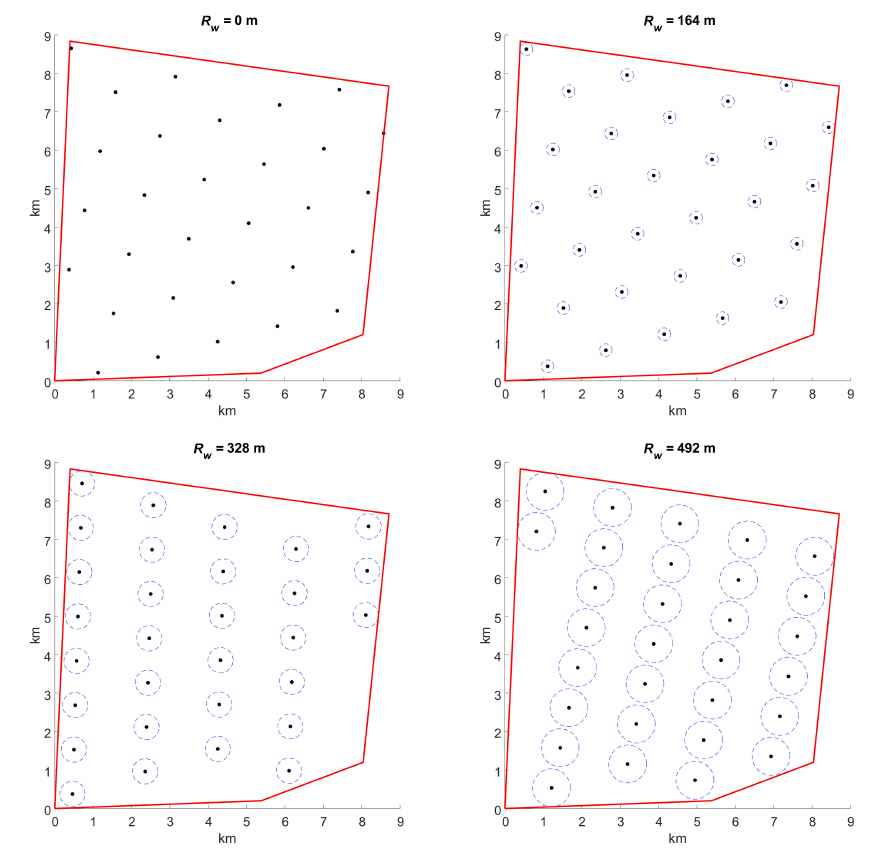
Figure 10. Optimal layouts obtained for the different R w analysed in Case 3. Table 4. Main techno-economic data obtained for Case